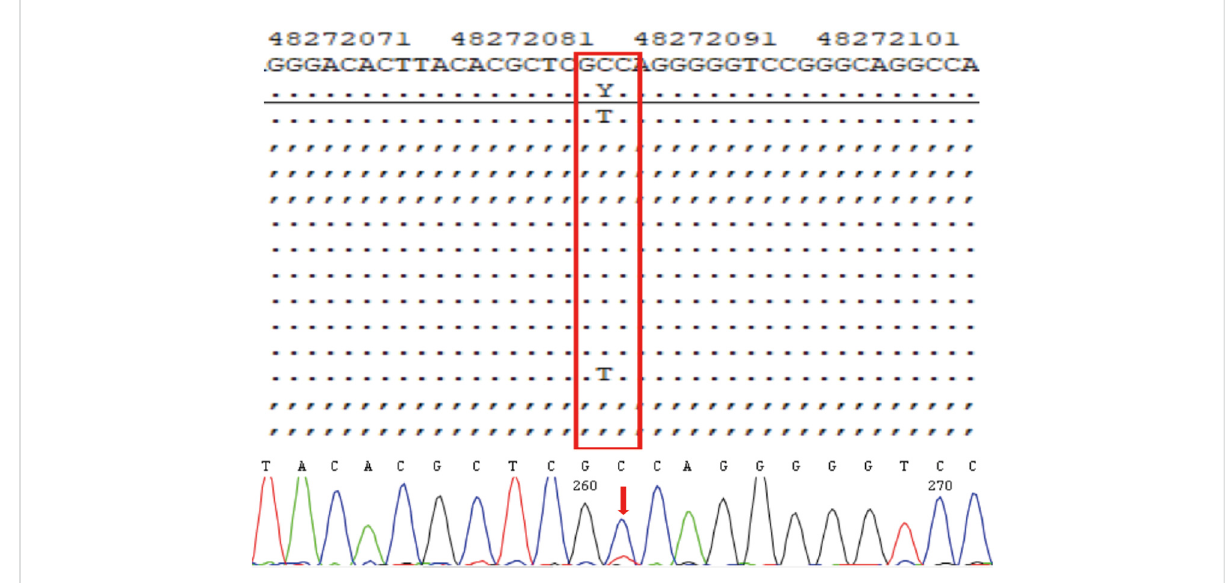
FIGURE 2 High-throughput sequencing results and electropherogram of fi rst-generation DNA sequencing for male peripheral blood cells.